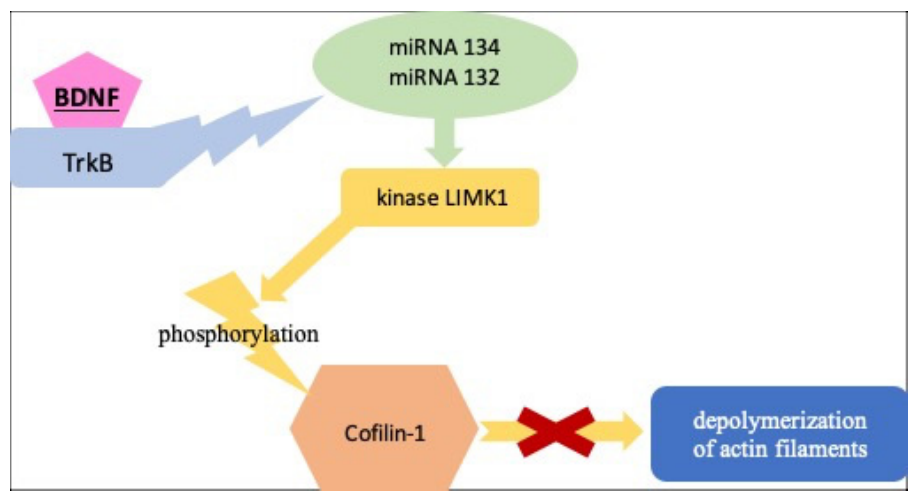
Figure 5. The role of BDNF in actin polymerization (based on [14,28–30]); BDNF—brain-derived neurotrophic factor, TrkB—Tropomyosin receptor kinase B, LIMK1—LIM Domain Kinase 1.